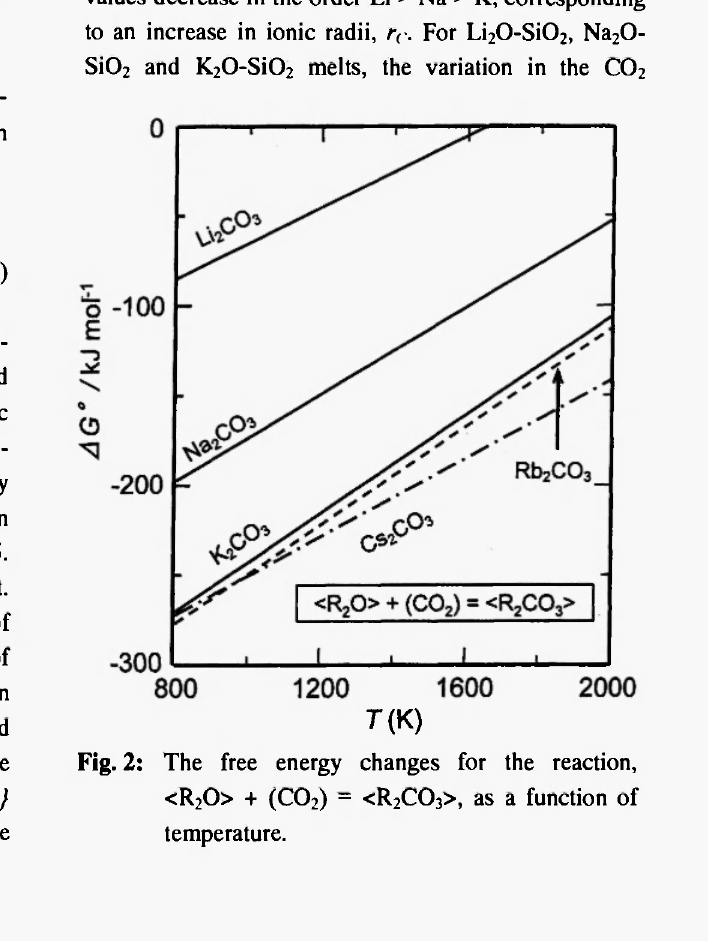
Fig. 1: Variations of the C0 2 solubilities as a function of glass composition at 1473 Κ for R 2 0- Si0 2 melts 15,6,1/.